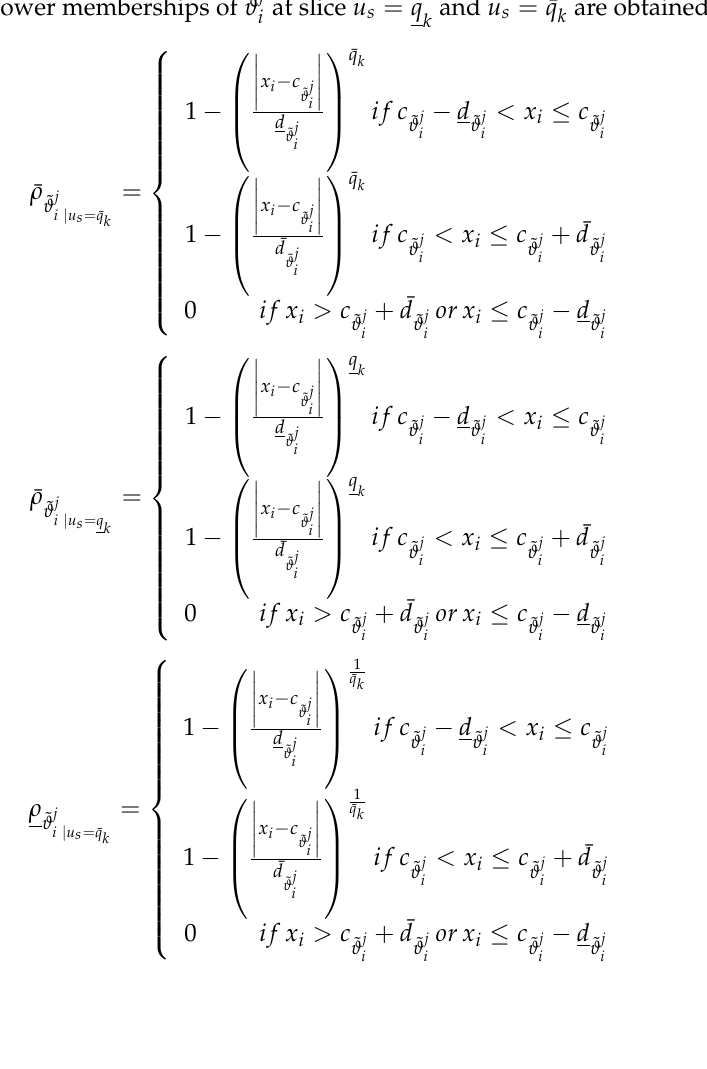
at slice u s = q and u s = ¯ q are obtained as [63]: k i k